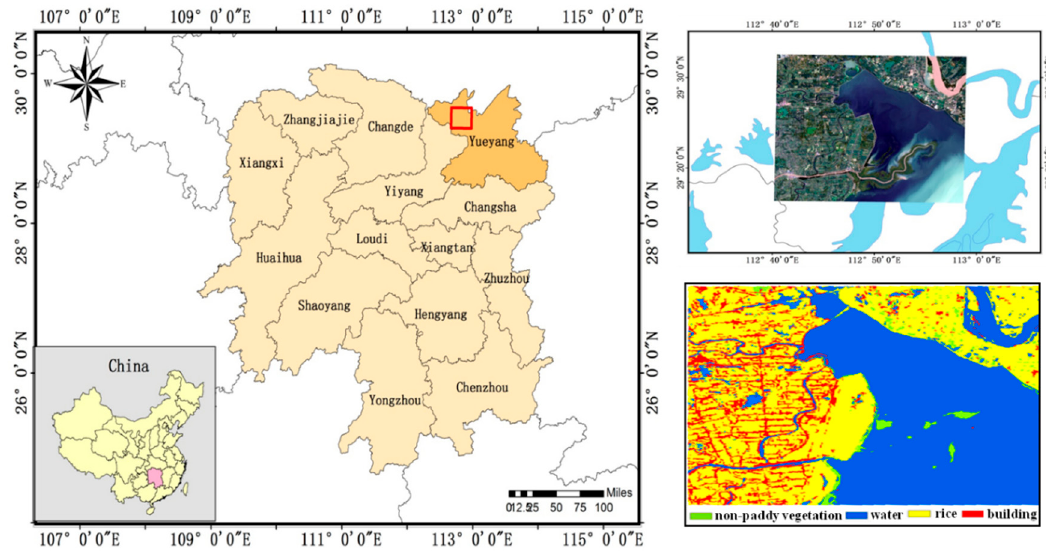
Figure 4. Location and land cover types in the study area.